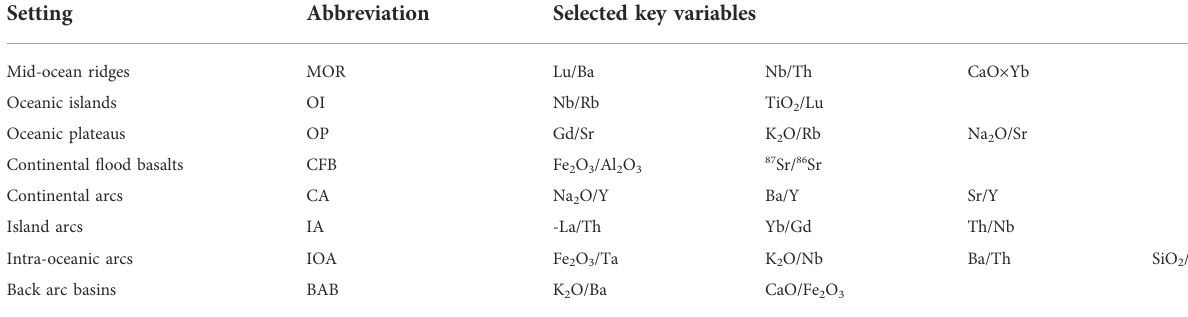
TABLE 1 SMR-based key geochemical variables for different tectonic settings. Variables are given in order of absolute values of w at a λ that corresponds to the fi rst fi ve variables while increasing λ .